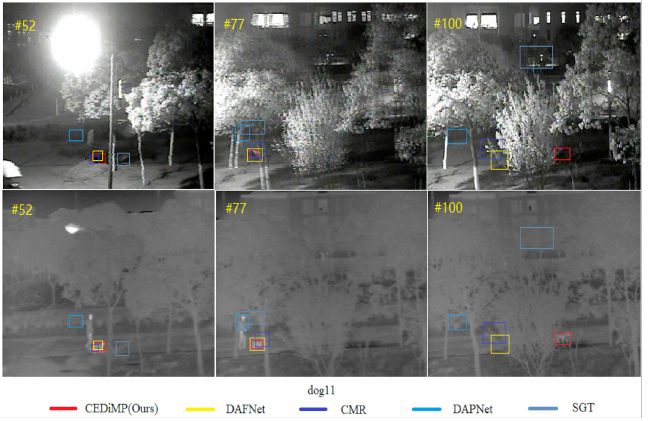
Figure 8. Qualitative comparison results on dog11 image sequences in RGBT234.